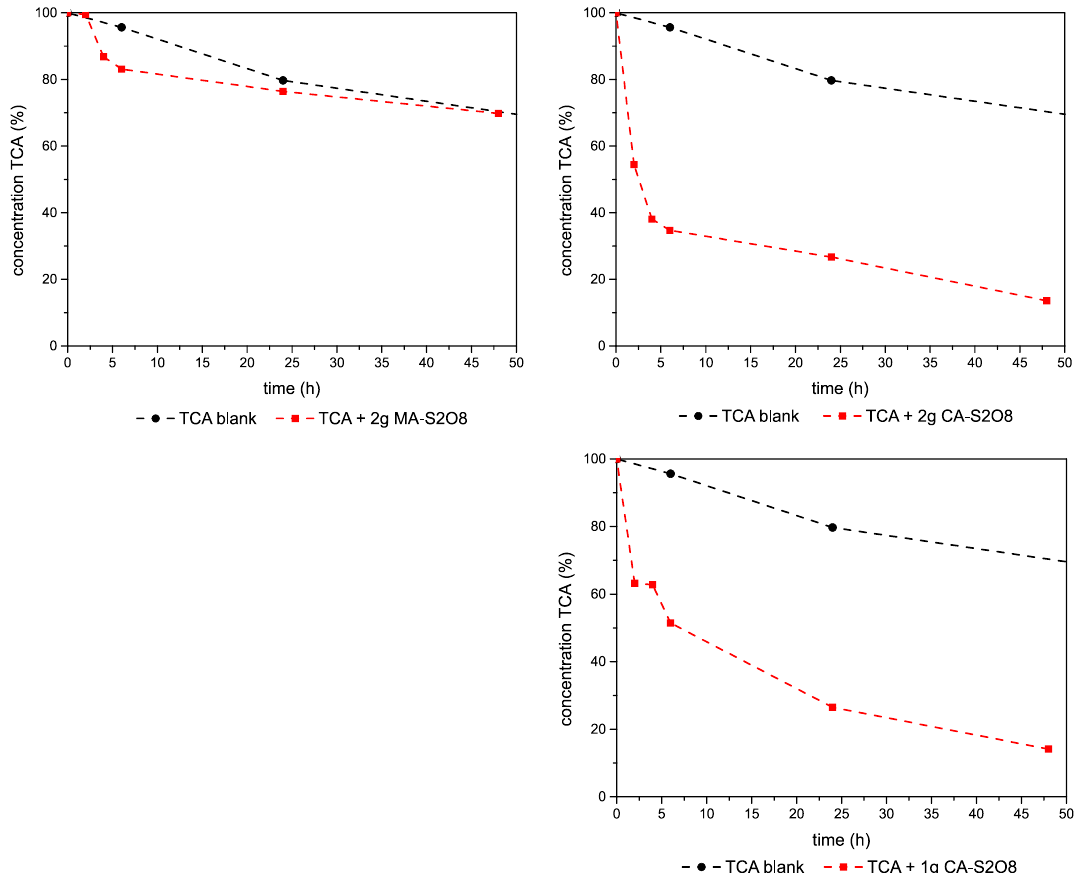
Figure 8. Results of the HS-PTV-GC-MS measurements with peroxydisulphate intercalated LDHs using 1,1,2-trichloroethane as the contaminant. Contaminant concentration (%) in solution over time (h). Blank solution as black dots, experimental solution as red squares.